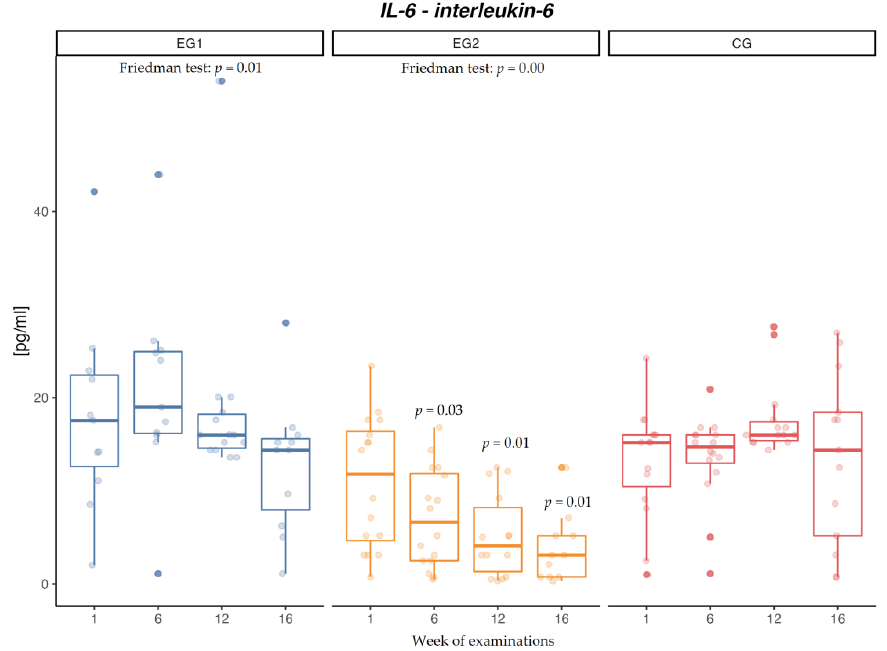
Figure 3. Changes in interleukin-6 (IL-6) concentration [pg/mL] in the aerobic group (EG1), aerobic- resistance group (EG2), and control group (CG) during weeks of examinations.